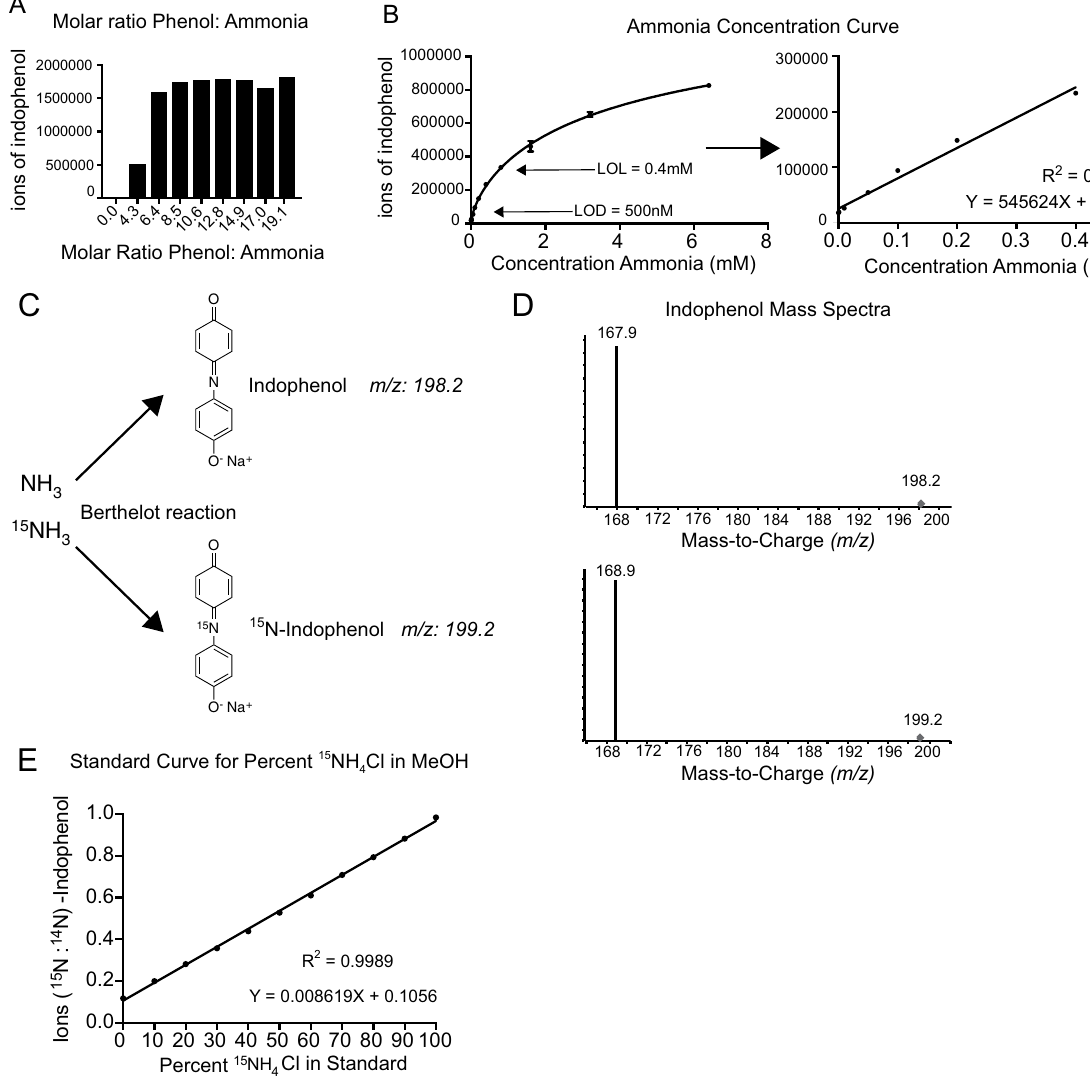
reaction in a cell lysate, we used a volumetric ratio of 10:1 of each solvent to lysate. First, we assayed the specificity of indophenol for the MS Berthelot assay. Indophenol was undetectable in mammalian cell lysates, and was only detected after the Berthelot reaction (Fig. 3D). Thus, as indophenol is not a mammalian metabolite, it can be dis- tinctly measured after reaction with ammonia in the complex matrix of a polar metabolite extraction. We also evaluated the sensitivity of ammonia detection from mammalian cells. We spiked a concentration curve of ammonia into 293T lysates, generating a linear standard curve with an R 2 value of 0.998 (Fig. 3C). Furthermore, ammonia increased linearly with a dynamic cell range of 500,000 to 2.5 million cells (R 2 = 0.9991) (Fig. 3D). To directly assay ammonia concentrations within mammalian cells, we performed the MS Berthelot assay from a cell lysate not spiked with ammonia. We used the standard addition technique to generate a standard curve by spiking ammonia into 293T cell lysates (0.0–0.8 mM ammonia) (Fig. 3E). In 293T cells, we measured 100 femtomoles of ammonia per cell (Fig. 3F), consistent with levels detected using a commercial ammonia assay.